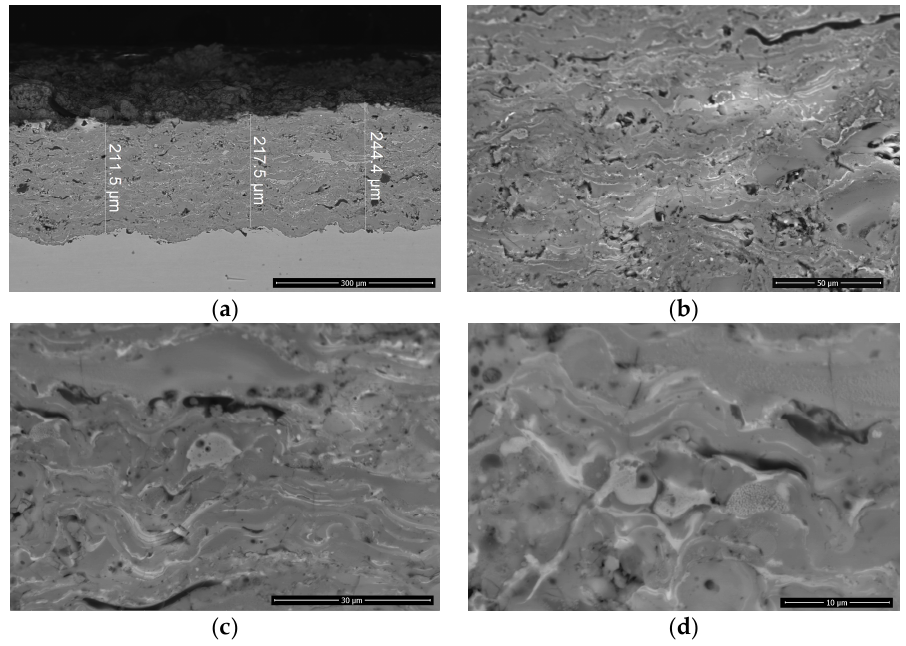
Figure 4. XRD patterns of the ( a ) zircon sands, and ( b ) the zircon ‐ based ceramics coating.